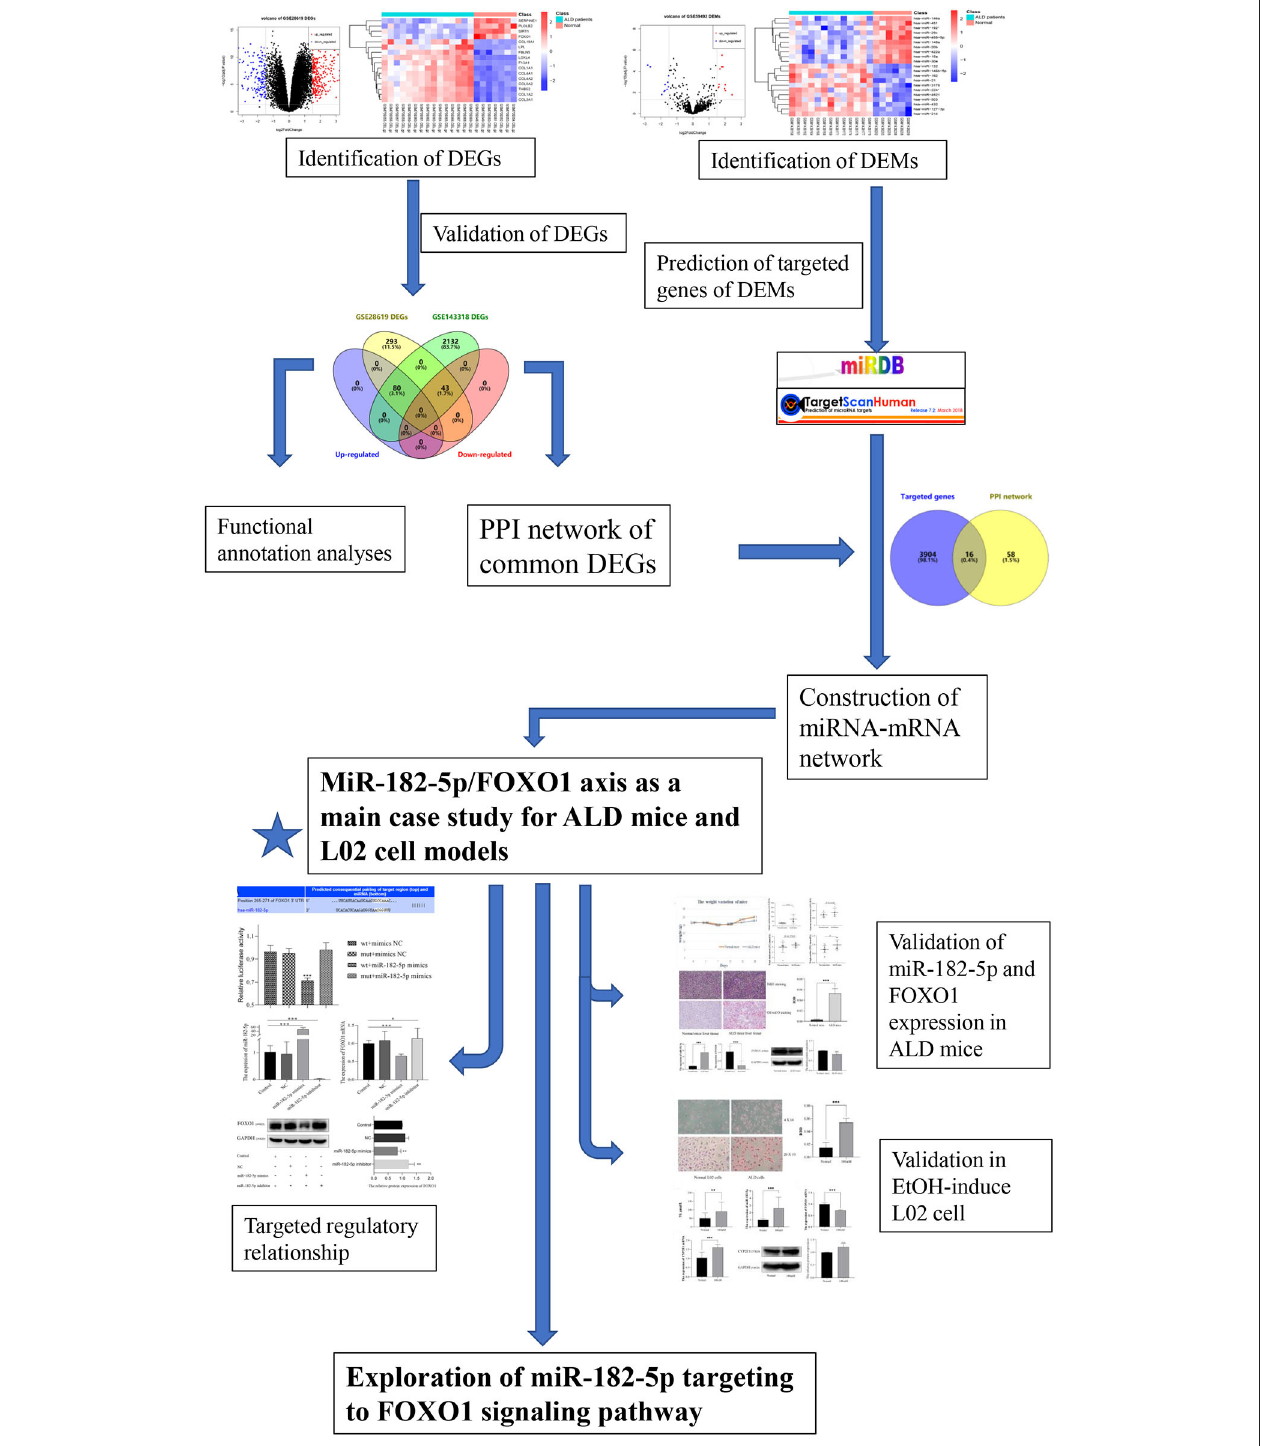
FIGURE 1 | Flowchart of the current study. DEGs, differentially expressed genes; DEMs, differentially expressed miRNAs; ALD, alcoholic liver disease; PPI, protein–protein interaction.